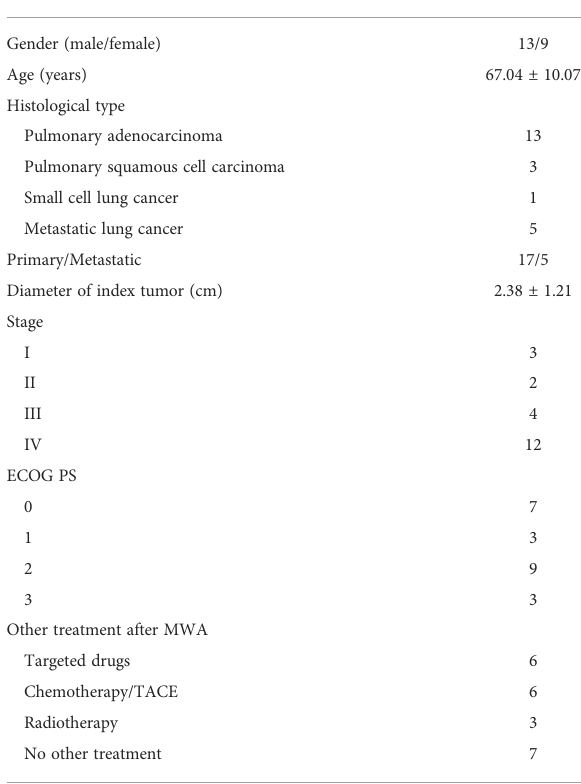
TABLE 1 Characteristics of study